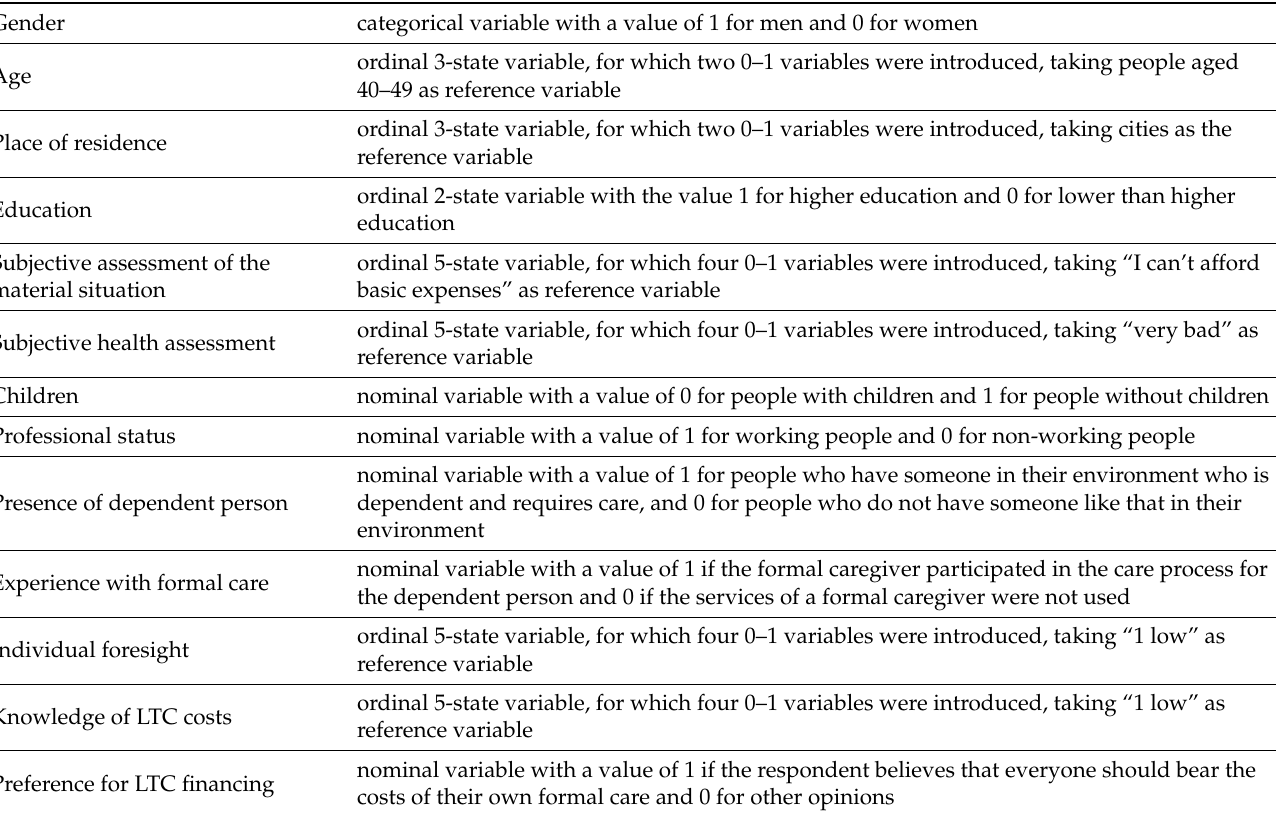
Table 3. Explanatory variables in the model explaining the propensity to purchase